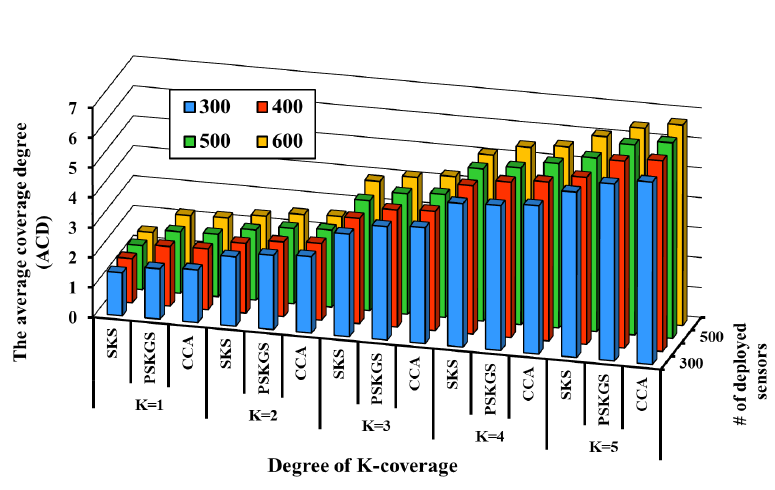
Figure 14. The # of Active Sensors (ASs) in CCA [31], PSKGS and SKS in a round.